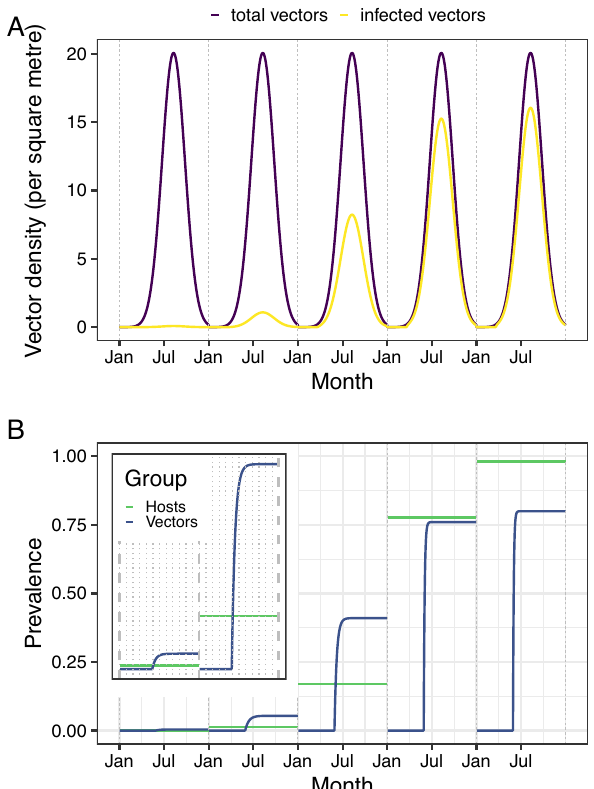
Figure 3. In the early stages of the epidemic, the apparent prevalence of X. fastidiosa in vectors increases faster than that in hosts. ( A ) Although the total density of P. spumarius is assumed to be fixed between years, the density of infected vectors increases each year. This plot shows the modelled density of P. spumarius and the density of X. fastidiosa -infected P. spumarius over the course of 5 years. ( B ) The apparent prevalence of X. fastidiosa infection is higher in vectors than in hosts in the early stages of a new epidemic. This plot shows how the modelled apparent prevalence of X. fastidiosa in hosts contrasts with that in vectors, over the course of 5 years. The inset plot shows the estimates from the first 2 years in more